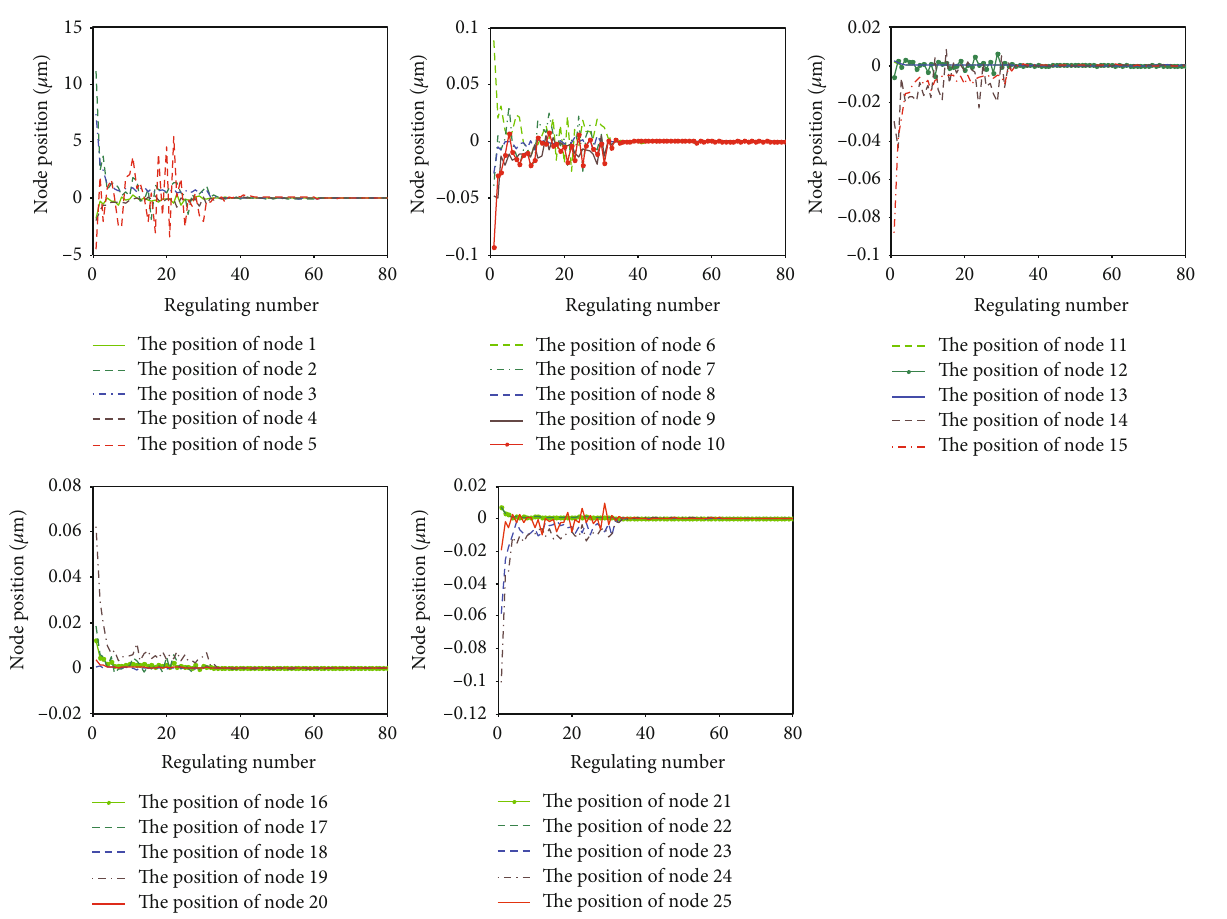
Figure 4: Q-learning adjustment curve with disturbance of 15%.